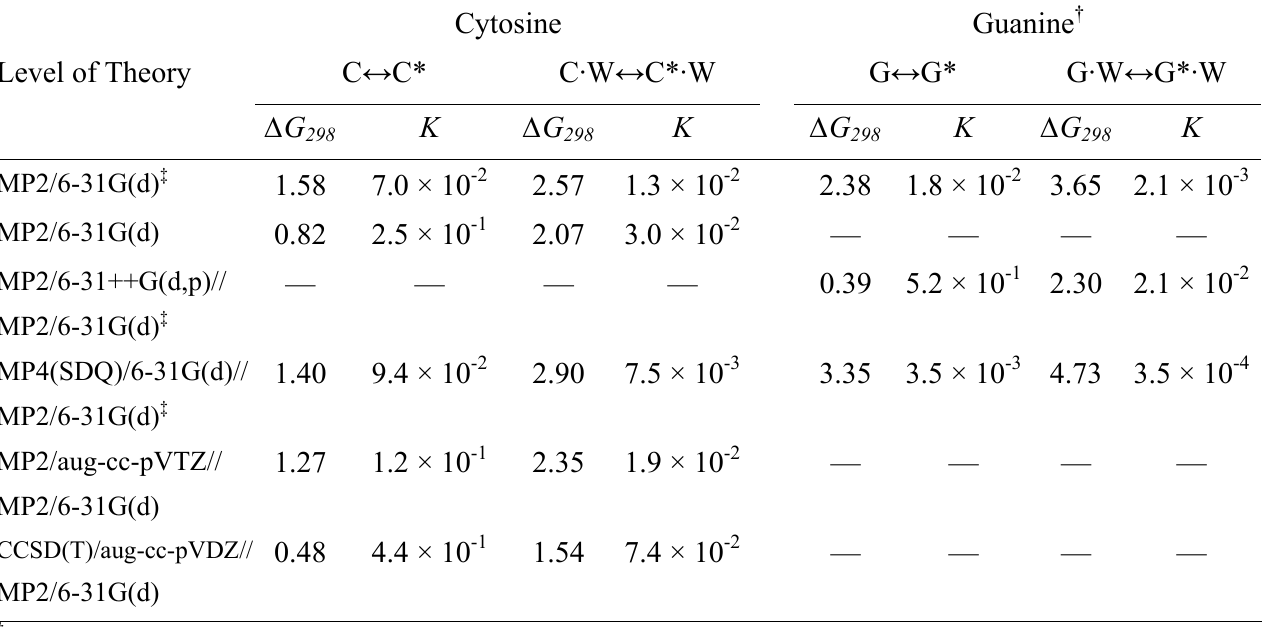
in kcal mol -1 ) and Corresponding Equilibrium Constants (K) for Table 1. Gibbs Free Energies ( ∆ G 298 the Equilibria (2) and (3) and Corresponding Equilibria for